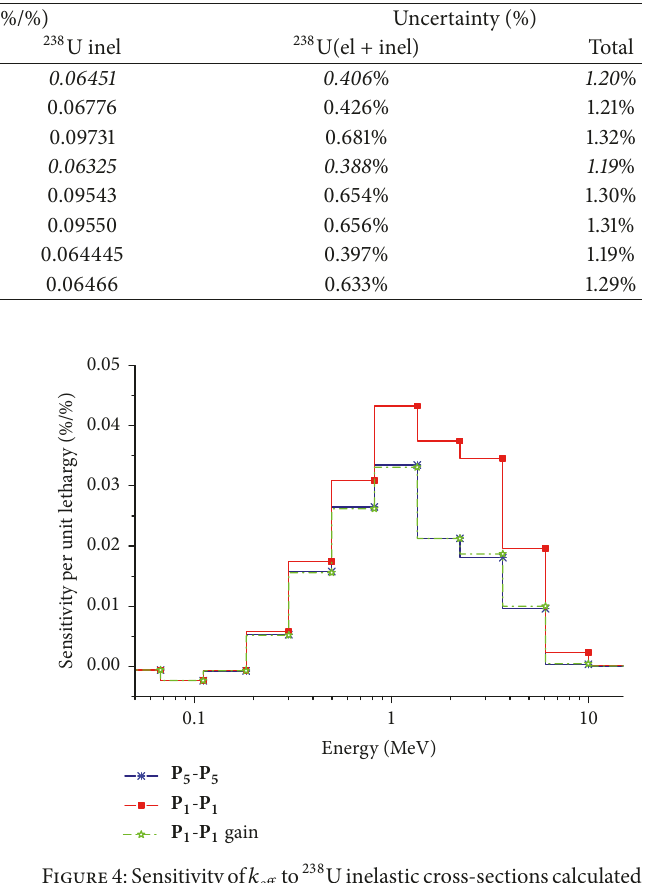
Figure4:Sensitivityof 𝑘 eff to 238 Uinelasticcross-sectionscalculated by SUSD3D/ANISN